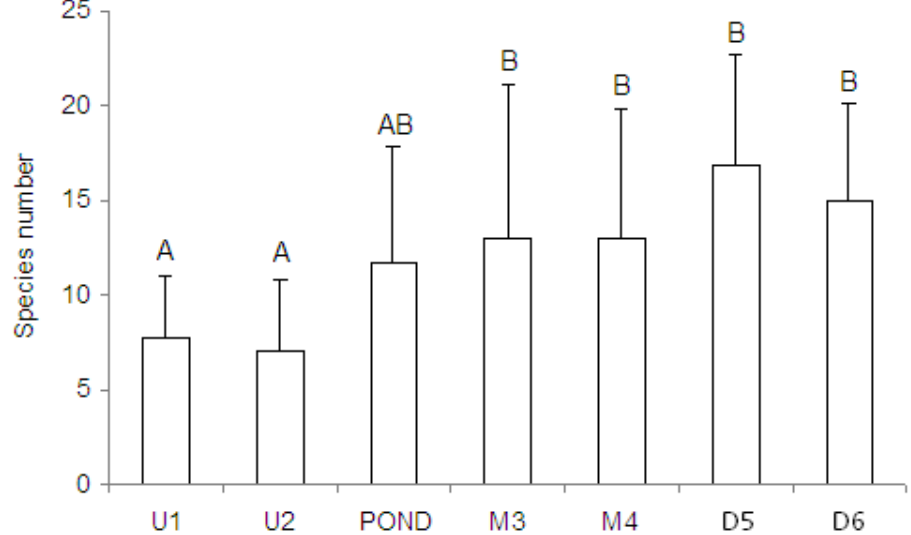
Figure 2. Spatial changes of mean + SD zooplankton species numbers at two sites in the upper section (U1, U2), in POND, at two sites in the middle section (M3, M4), and at two sites in the downstream section (D5, D6) of the Bukówka stream. Different letters on the columns show significant differences between sites (P < 0.05).